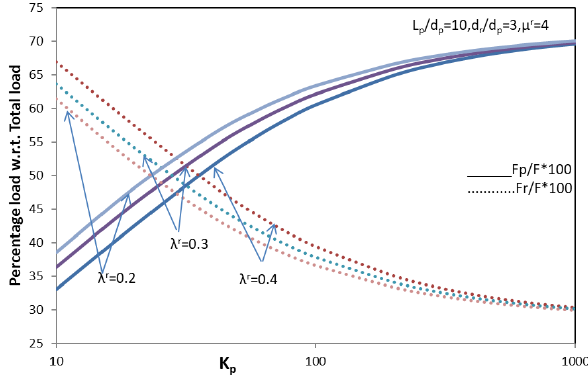
Figure 22: Variation of percentage load w. r. t. total load with the comparative strengthening of GP, K strengthening of GP, λ r , on a partially strengthen GP–raft foundation (L /d =10, d /d =3,μ r p p r p